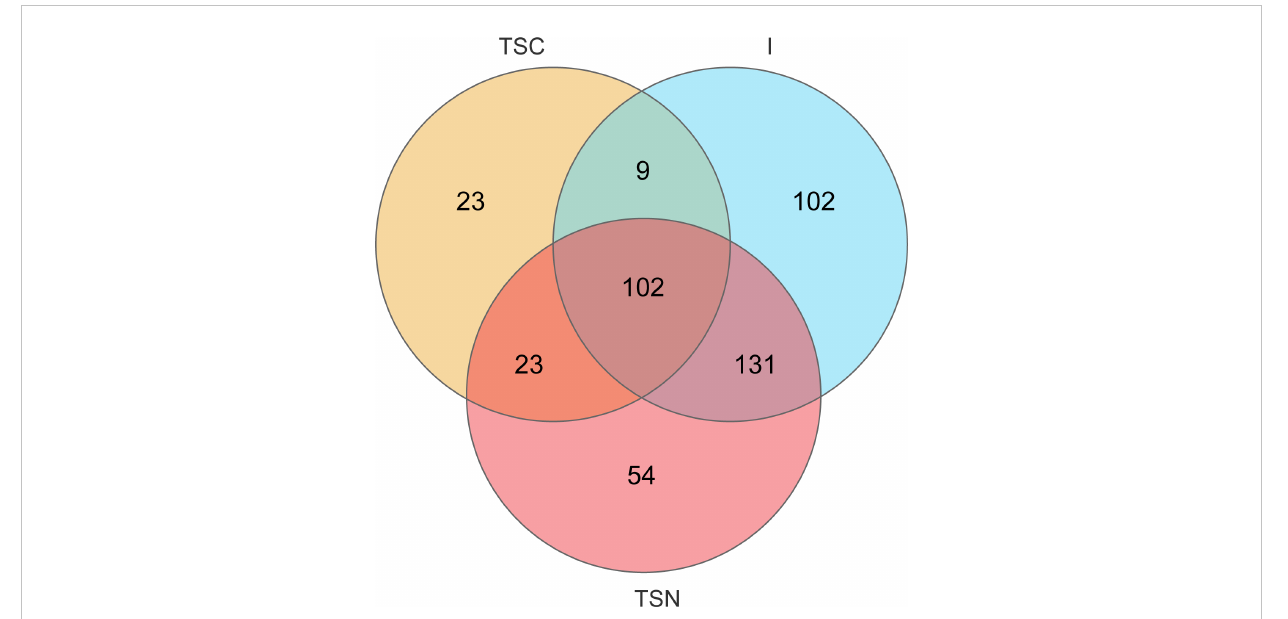
FIGURE 5 VENN diagrams at genus level. VENN diagram was used to represented the common and unique genera among different groups. TSC, Transitional stools of caesarean delivered neonates; I, Transitional stools of caesarean delivered neonates with the treatment of swabbing maternal vaginal fl uid; V, Vaginal fl uids of the pregnant women who underwent caesarean